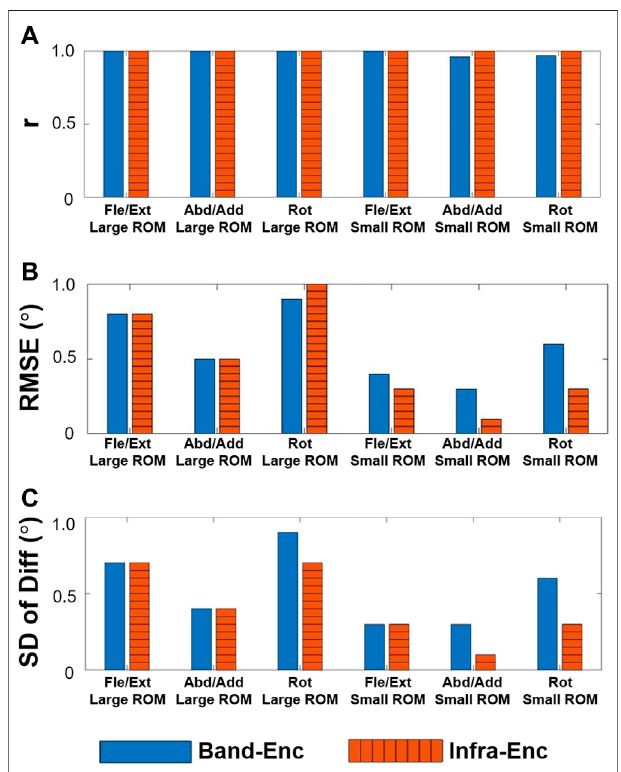
FIGURE 10 | WSM-Enc (blue solid) and Infra-Enc (orange striped) comparison results. High correlation coef fi cients (A) and relatively small discrepancies, as shown by the RMSE (B) and SD of Diff (C) results, were consistently observed between the two